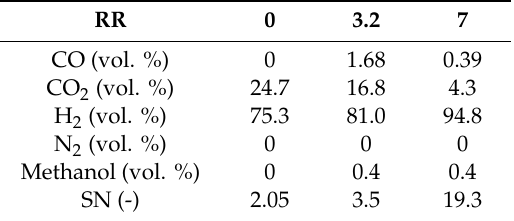
Table 3. Simulation results: reactor inlet gas composition for the pure CO 2 scenario at a certain RR. RR 0